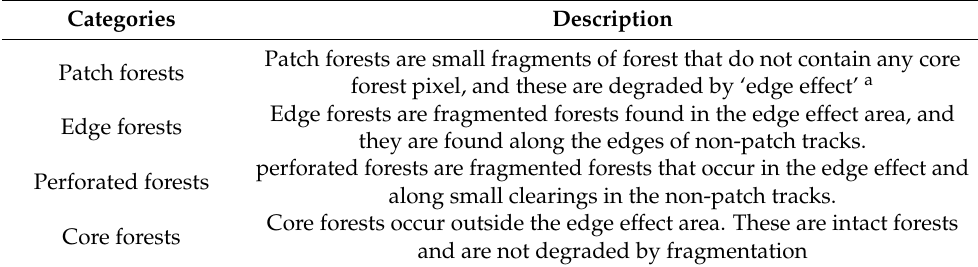
Table 1. Categories of forests and their descriptions. Categories Description Patch forests are small fragments of forest that do not contain any core Patch forests forest pixel, and these are degraded by ‘edge effect’ a Edge forests are fragmented forests found in the edge effect area, and Edge forests they are found along the edges of non-patch tracks. perforated forests are fragmented forests that occur in the edge effect and Perforated forests along small clearings in the non-patch tracks. Core